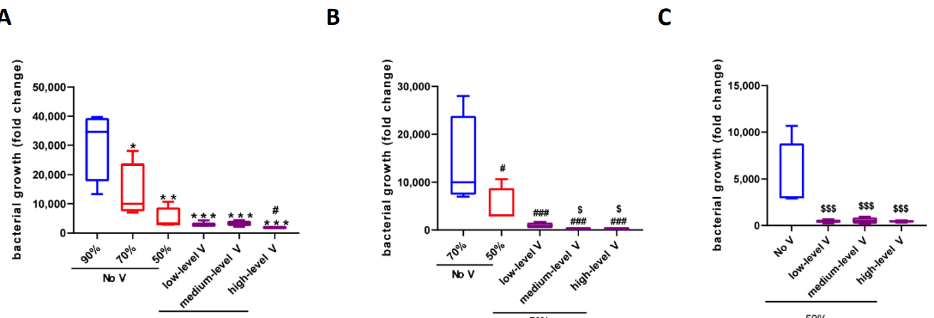
Figure 4. The bacterial growth (fold change compared to the base value measured after washing in tap water, before placing in the cabinets) in meat under different working conditions at 26 °C. ( A ) no ventilation and different ventilation levels at 90%, 26 °C; ( B ) no ventilation and different ventilation levels at 70%, 26 °C; ( C ) no ventilation and different ventilation levels at 50%, 26 °C. * p < 0.05 vs. no ventilation 90%; ** p < 0.01 vs. no ventilation 90%; *** p < 0.001 vs. no ventilation 90%; # p < 0.05 vs. no ventilation 70%; ### p < 0.001 vs. no ventilation 70%; $ p < 0.05 vs. no ventilation 50%; $$$ p < 0.001 vs. no ventilation 50%. Table 1. The bacterial growth (fold change) in meat under different working conditions at 26 °C. 26 °C No V